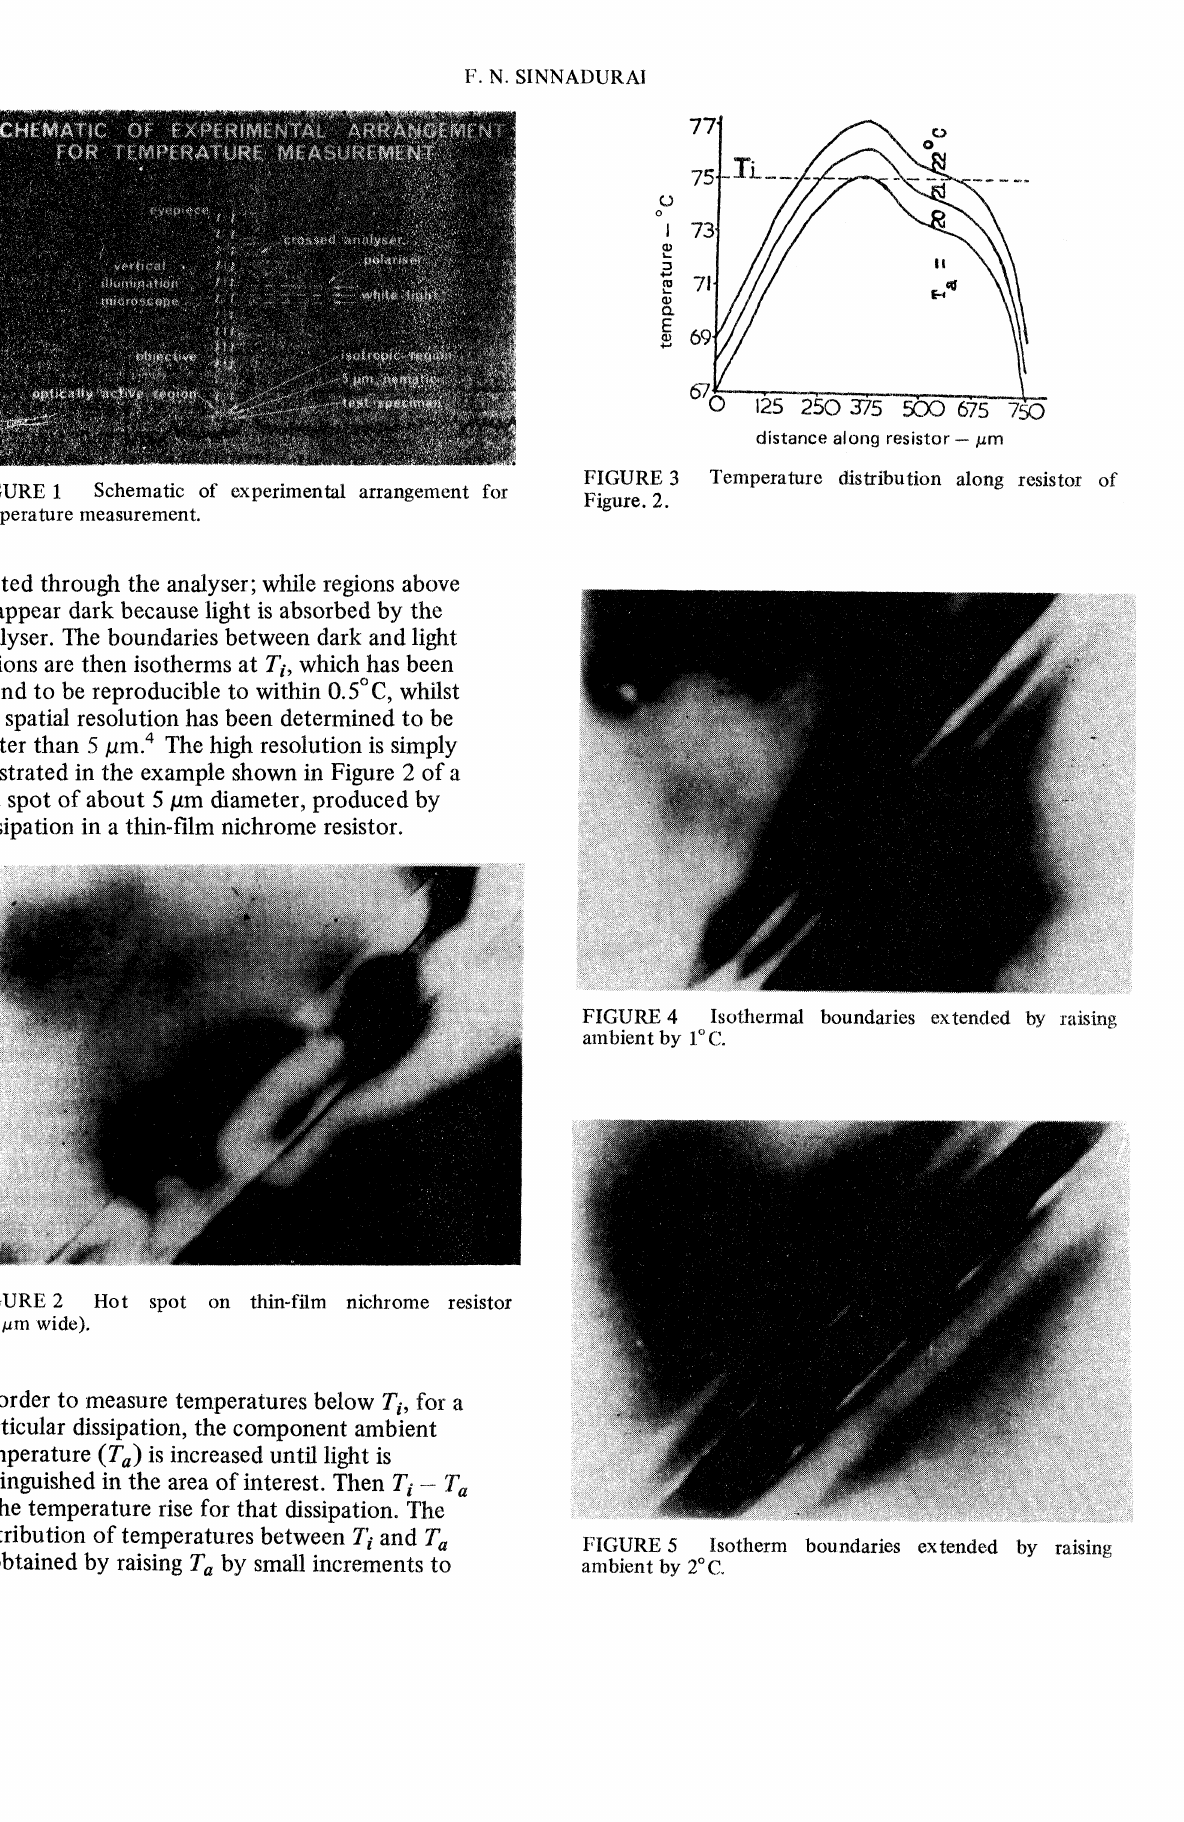
FIGURE 5 Isotherm boundaries extended by raising ambient by 2